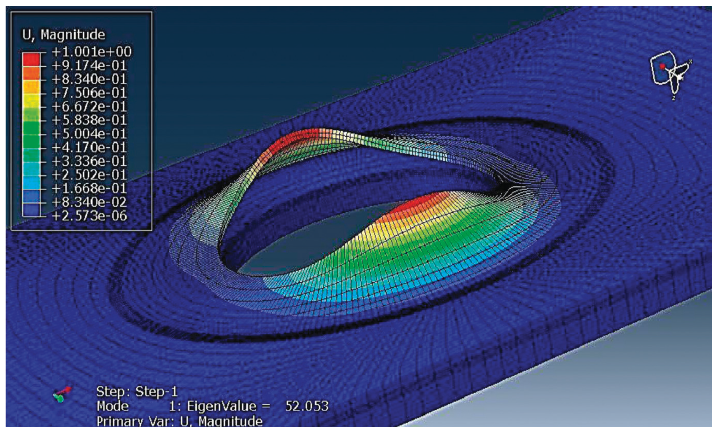
Figure 28: First tension mode for plate with 1/5 length to width ratio and 0/2 radius to width ratio with 0/75 yielding ratio.